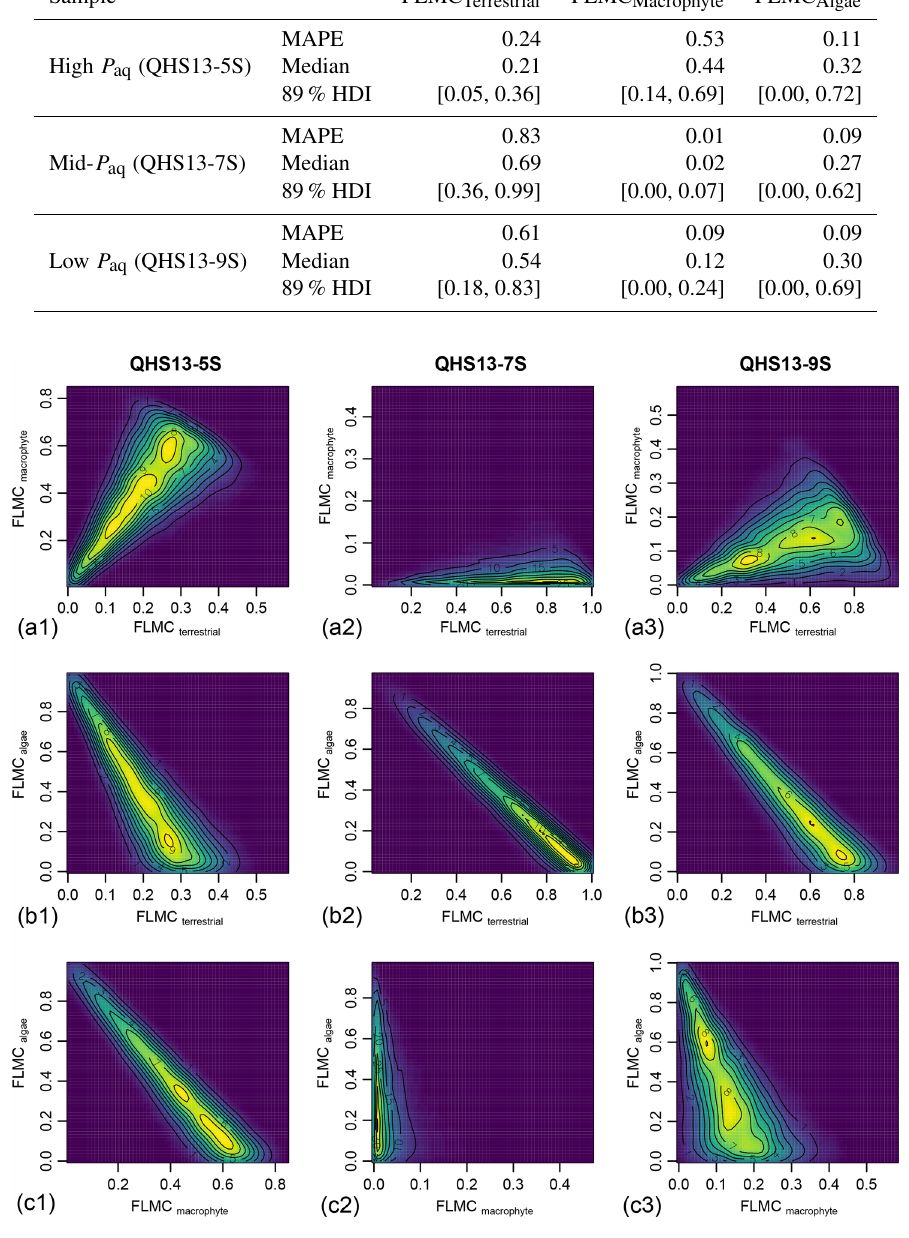
Figure 6. Bivariate density plots of the posterior densities of fractional leaf mass contribution (FLMC) of terrestrial plants, aquatic macro- phytes, and algae in published lake surface sediment samples from Lake Qinghai (Liu et al., 2015).